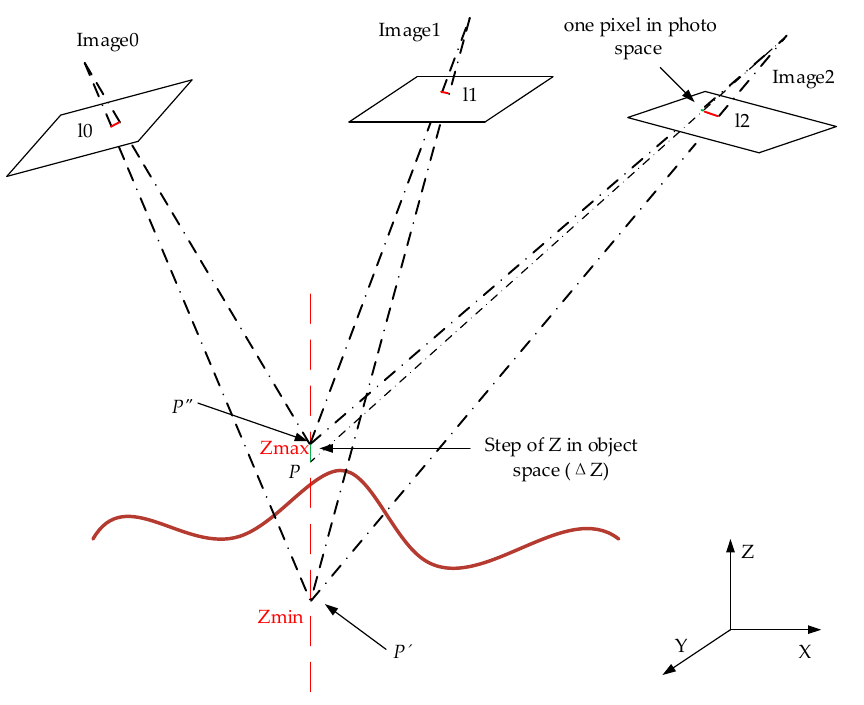
Figure 3. Robust cost calculation of grid point P with vertical line locus. This figure shows how to obtain the elevation step in object space corresponding to one pixel in photo space. Specifically, given a grid point P (X, Y) and its possible elevation range ( Z min, Z max), firstly we project the vertical line (from P ′ ( X , Y , Z min) to P ″ ( X , Y , Z max)) to all the visible images, thus a locus is generated on each image. Secondly, the minimum pixel-wise back-projected distance of the longest locus ( l 2) is used as the elevation step which is located at P ″ ( X , Y , Z max).